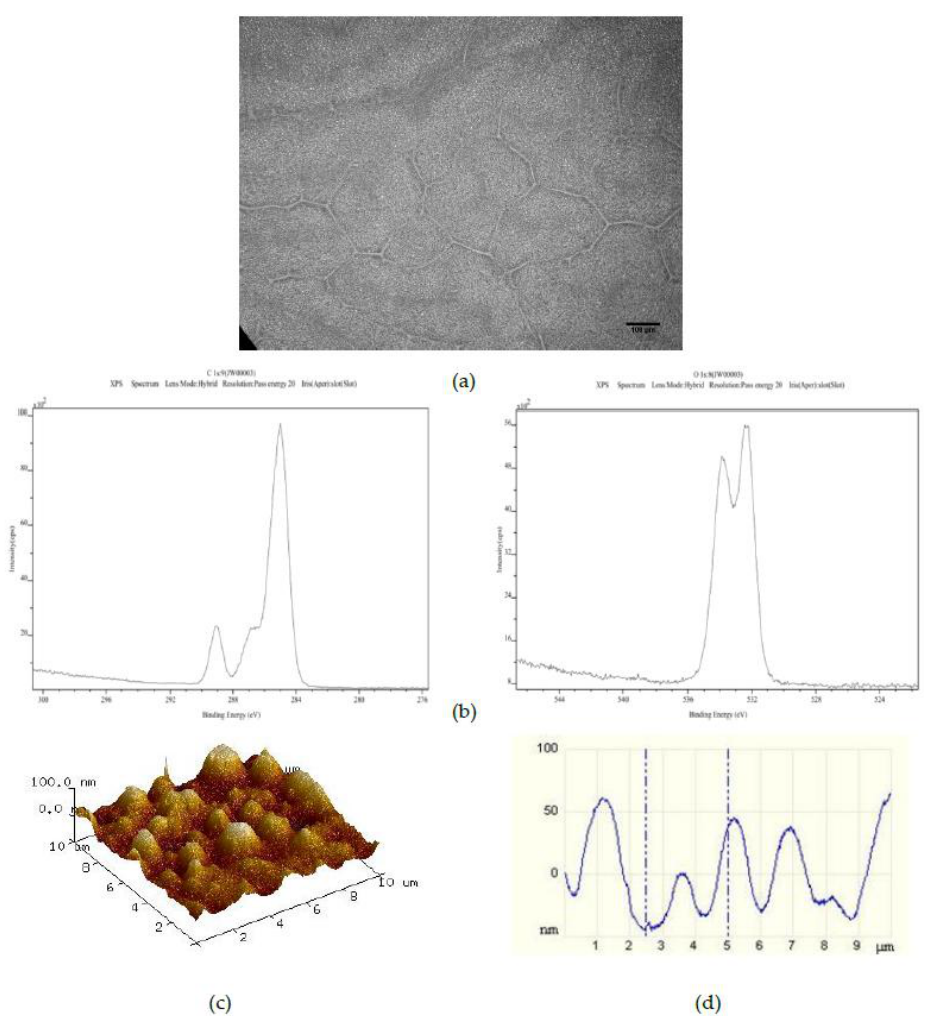
Figure 3. Characterisation of 25PS/75PMMA + 750 films by way of ( a ) optical microscopy (×20); ( b ) C1s ( left ) and O1s ( right ) XPS spectra; ( c ) AFM 3D plots and ( d ) AFM line profile.